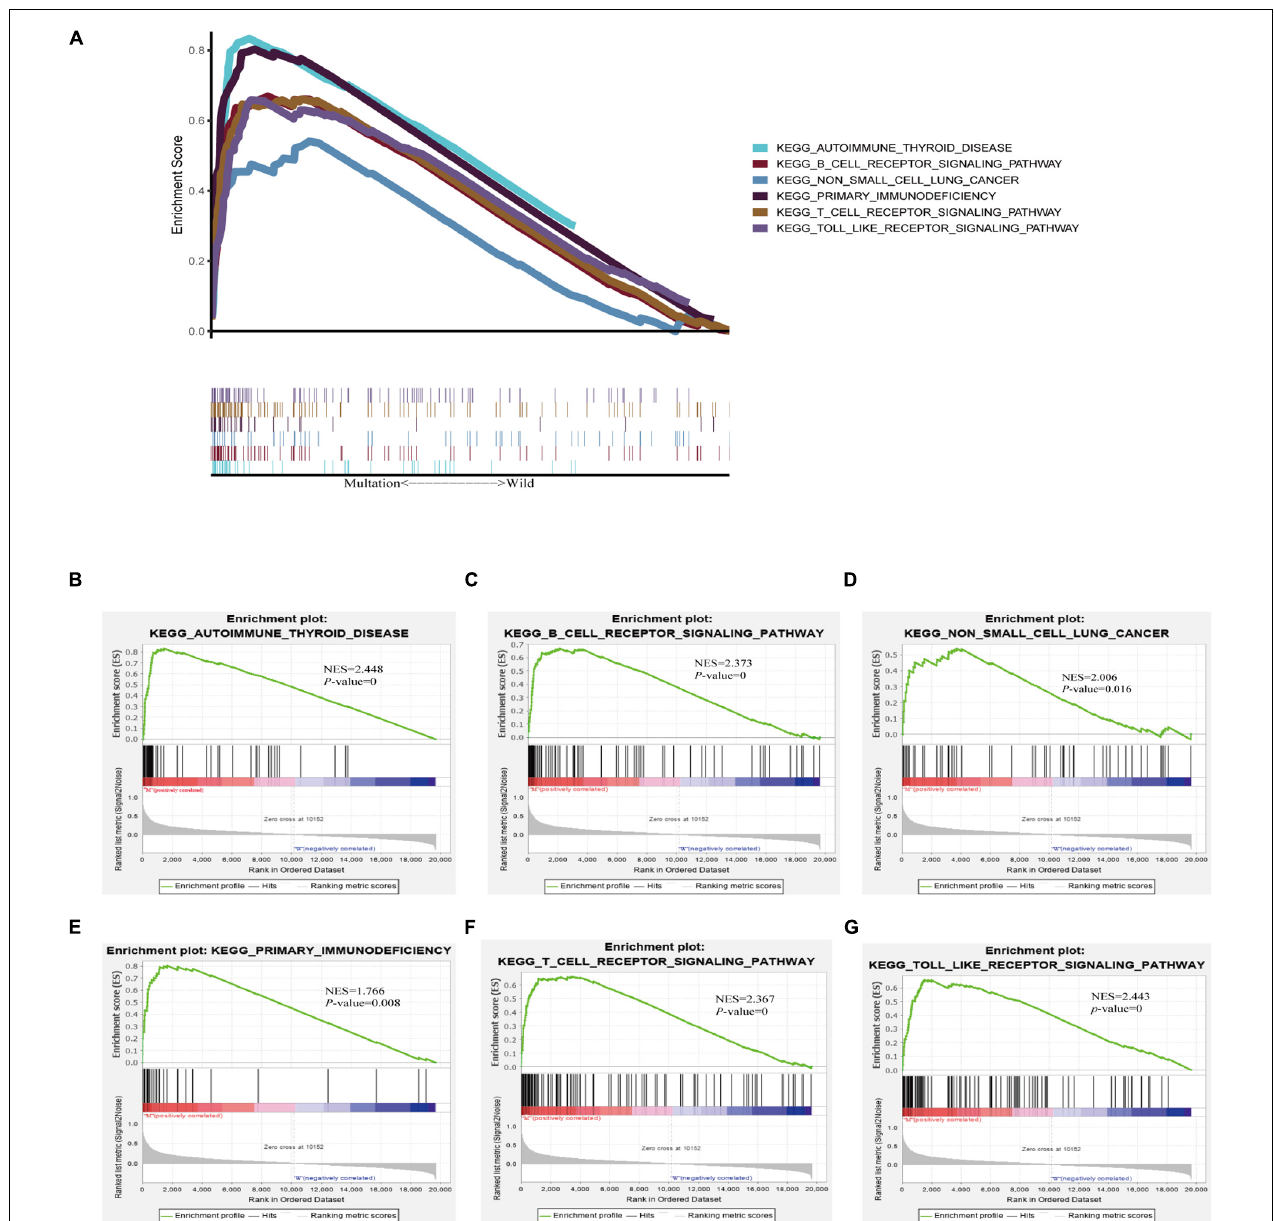
FIGURE 5 | TTN mutation is associated with immune-related pathways. Gene set enrichment analysis was performed with the TCGA. (A) Multiple gene enrichment plot shows that a series of gene sets are enriched in the TTN -mutant group. Gene enrichment plots display that a series of immune-related gene sets, including (B) autoimmune thyroid disease, (C) B-cell receptor signaling pathway, (D) non-small-cell lung cancer, (E) primary immunodeficiency, (F) T-cell preceptor signaling pathway, (G) Toll-like receptor singling pathway, are enriched in the TTN -mutant group. NES, normalized enrichment score. The p -value is shown in each